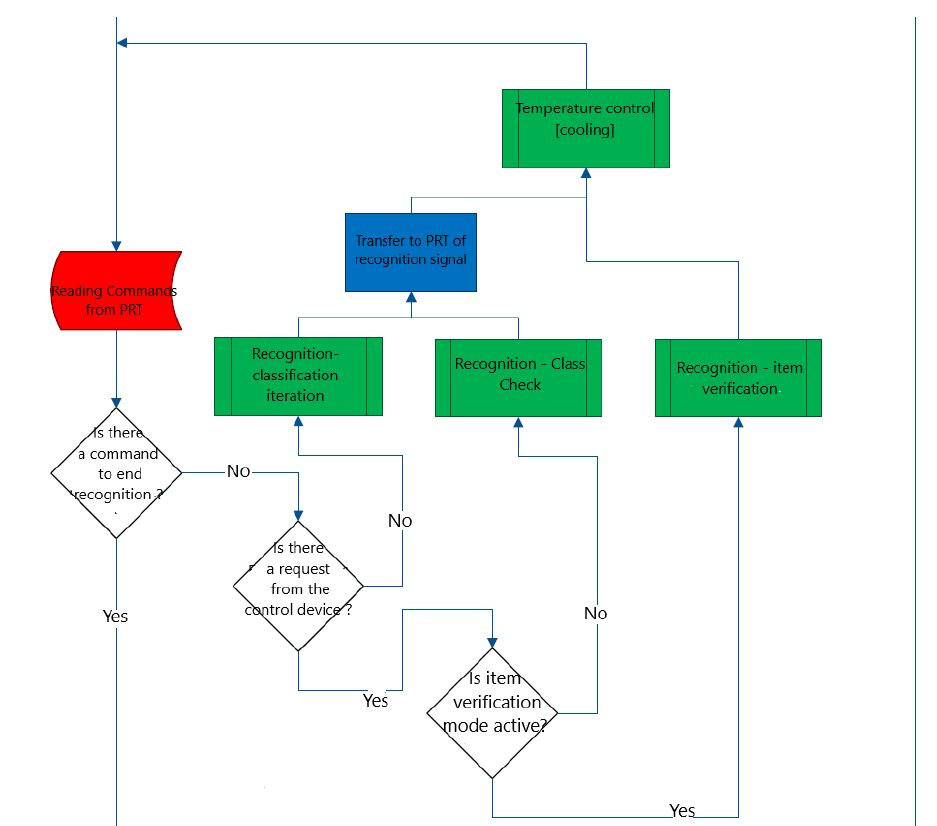
Fig. 2. Selecting an operating mode - a fragment of the main